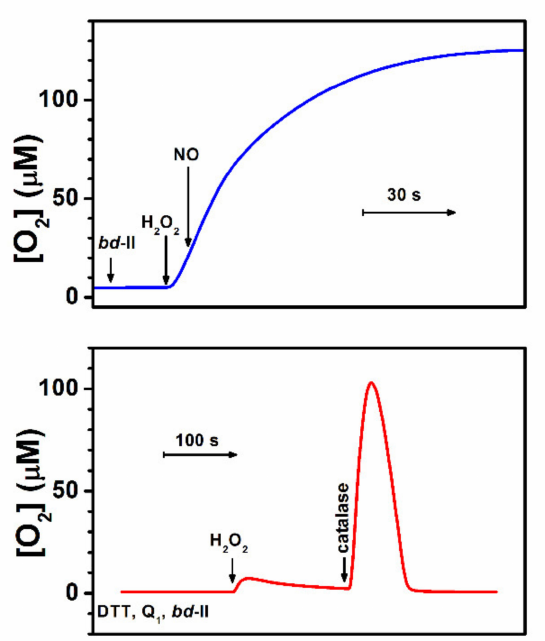
Figure 5. Catalase-like activity of the isolated cytochrome bd -II from E. coli . Top panel: The addition of 20 µ M NO does not affect О 2 evolution induced by the addition of 0.2 mM H 2 O 2 to the as-prepared enzyme (50 nM). Bottom panel: О 2 evolution is lacking if, before the addition of 1.32 mM H 2 O 2 , all O 2 is consumed and cytochrome bd -II (12.8 nM) is converted into the fully reduced state by 10 mM DTT and 250 µ M Q 1 . Subsequent addition of bona fide bovine catalase (2 µ g/ml) restores the reaction. Cytochrome bd -II was isolated from E. coli strain MB37 as described [38]. Changes in O 2 concentration were recorded using a high-resolution respirometer (Oxygraph-2k, Oroboros Instruments). Assays were performed at 25 ◦ C in 50 mM Na/phosphate buffer (pH 7.0) containing 0.1 mM ethylenediaminetetraacetate (EDTA), supplemented with 0.02% dodecyl- β -D-maltoside. Reduced catalase-like activity was determined in cell-free extracts of A. vinelandii UW136 [95]. In Alishewanella sp. WH16-1, cytochrome bd is also suggested to catalyze